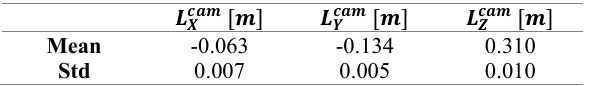
Table 2. Mean and standard deviation of the estimated of the estimated camera-antenna level arm vector in the camera reference system.